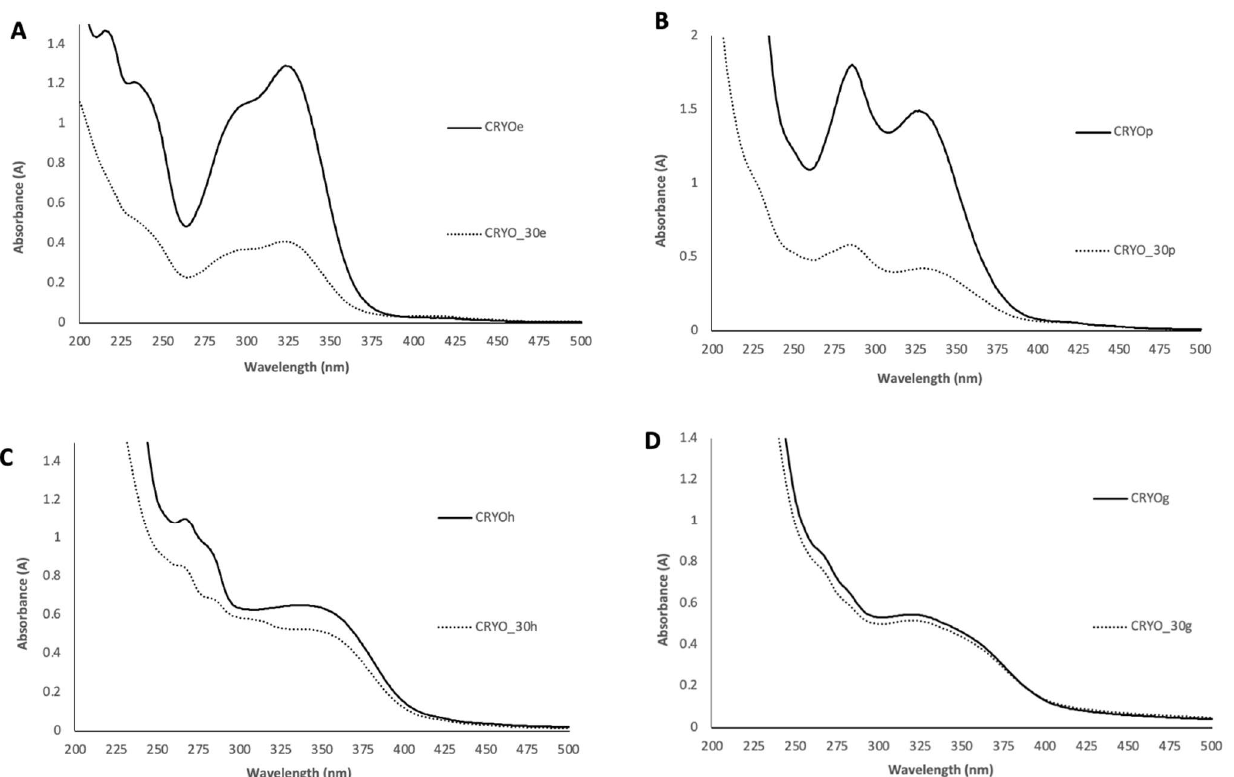
Figure 3. Spectrophotometric UV–Vis analysis of mother tinctures obtained in the oxidation stress test of Echinacea purpurea ( A ), Mentha piperita ( B ), Hypericum perforatum ( C ), and Ginkgo biloba ( D ) . UV–Vis spectra show the comparison between the cryoground “oxidation-free” reference (CRYO) and cryoground + 30 min air-exposed (CRYO_30) extract. Names of extracts in the legends are ordered in descending intensity of maximum absorption (between 318 and 323 nm).